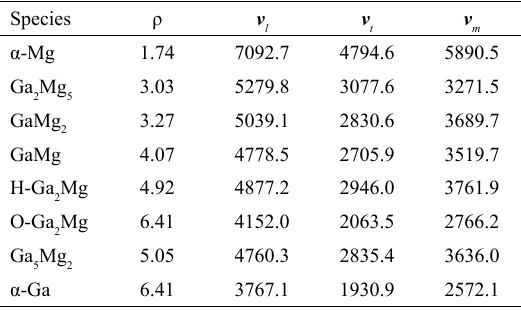
, m/s), average sound t